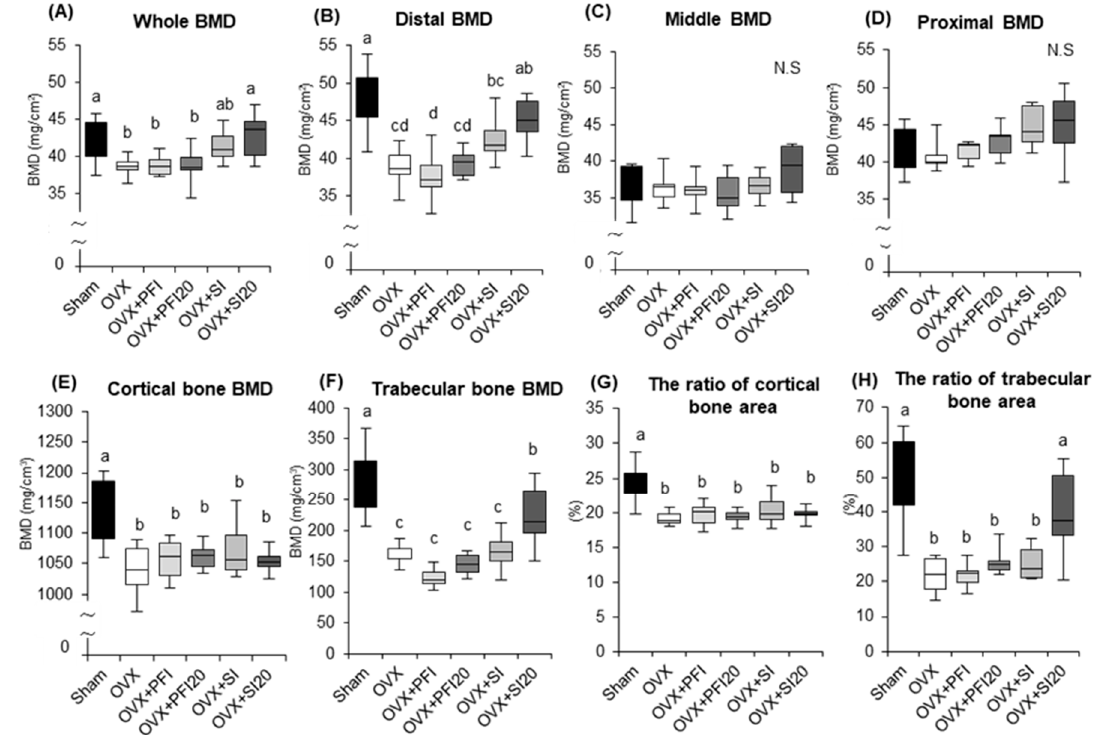
Figure 4. Bone mineral density (BMD) and parameters of the femurs in OVX mice in Experiment 2. ( A ) Whole BMD, ( B ) distal BMD, ( C ) middle BMD and ( D ) proximal BMD in femurs. ( E ) cortical bone BMD, ( F ) trabecular bone BMD, ( G ) the ratio of the cortical bone area and ( H ) the ratio of trabecular bone area of distal femur. Sham, sham-operated mice fed a control diet; OVX, ovariectomised mice (OVX) fed a control diet; OVX + PFI, OVX fed a Pueraria flower (kudzu) isoflavones (PFI) diet (the recommended human intake of PFI); OVX + PFI20, OVX fed a PFI20 diet (20-times the recommended human intake of PFI); OVX + SI, OVX fed an soy isoflavones (SI) diet (the recommended human intake of SI); OVX + SI20, OVX fed a SI20 diet (20-times the recommended human intake of SI) for 28 days. Values are the means ± SEMs ( n = 8). The statistical significance of di ff erences in femoral BMD was determined by analysis of covariance (ANCOVA) and a Bonferroni significant di ff erence test. Body weight was used as a covariate in the analyses of femoral BMD to adjust for possible confounding e ff ects. Di ff erences were considered significant when p < 0.05. a, b, c, d Mean values with di ff erent letters were significantly di ff